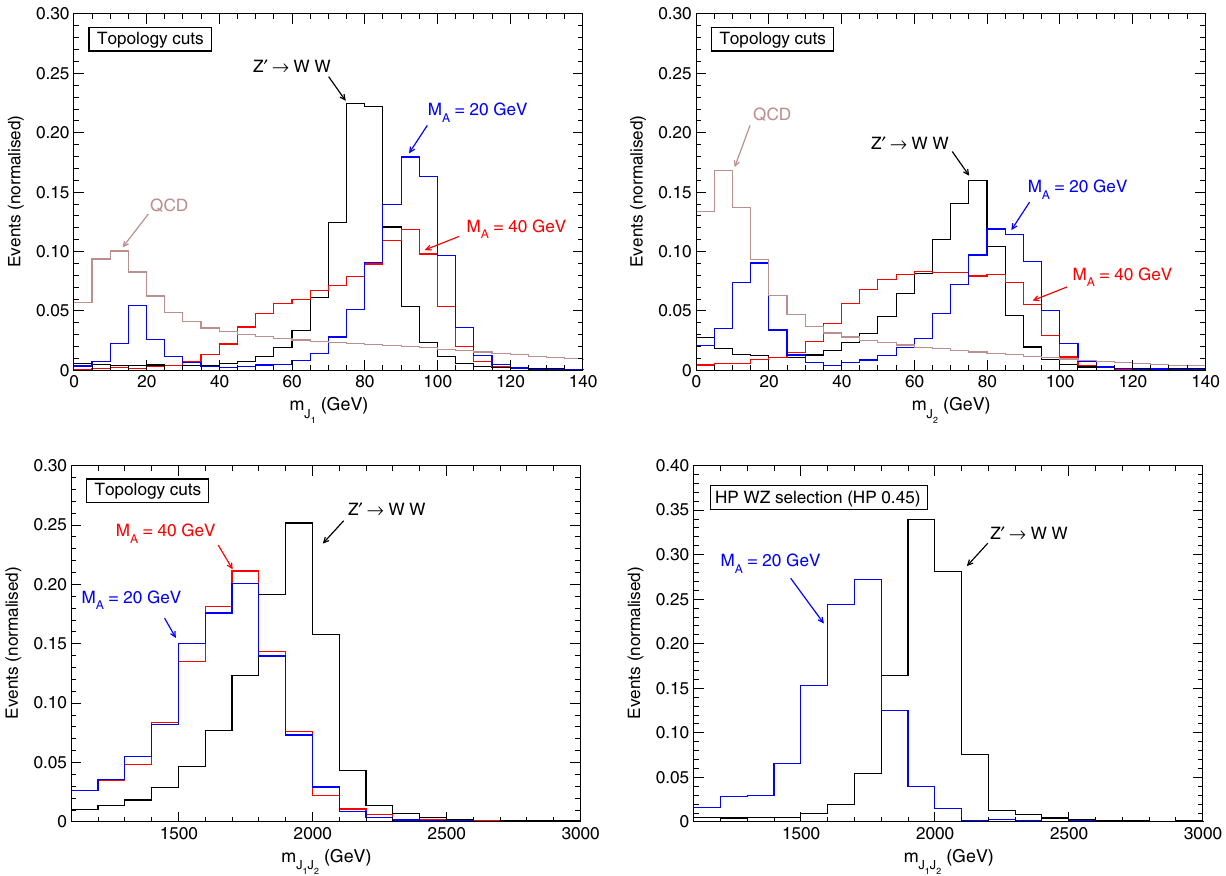
Fig. 5 Jet and dijet mass distributions for R → SS and Z (cid:8) → WW signals and the QCD dijet background for the CMS analysis